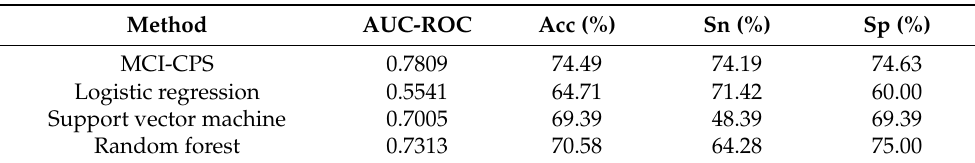
Table 3. Comparison of methods for predicting conversion from MCI to AD among four classifica- tion algorithms derived from ADNI-1.